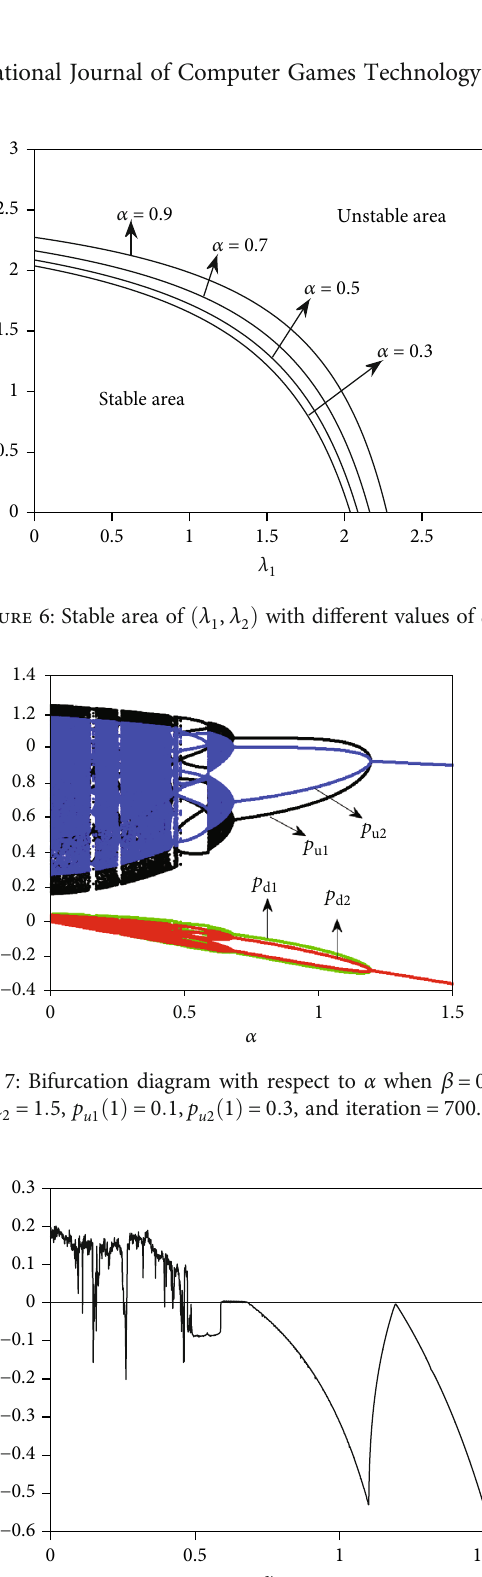
Figure 11: The maximum Lyapunov exponent with respect to β corresponding to Figure 10.